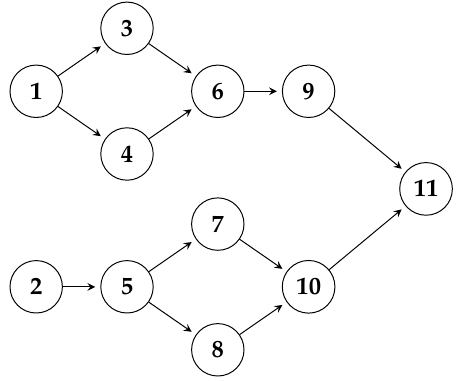
Figure 5. Task flow DAG topology.